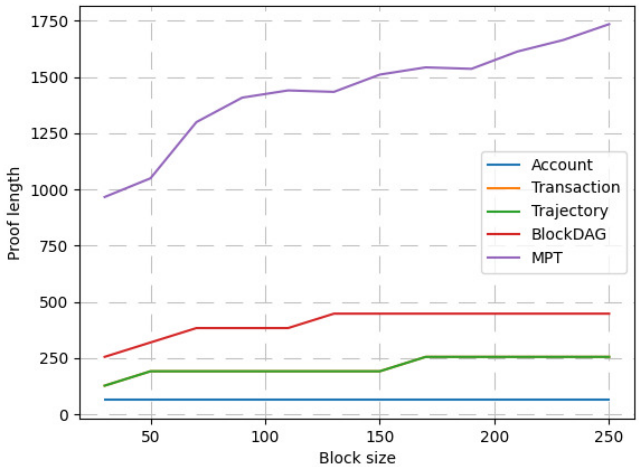
Figure 11. Performance Analysis of Vector